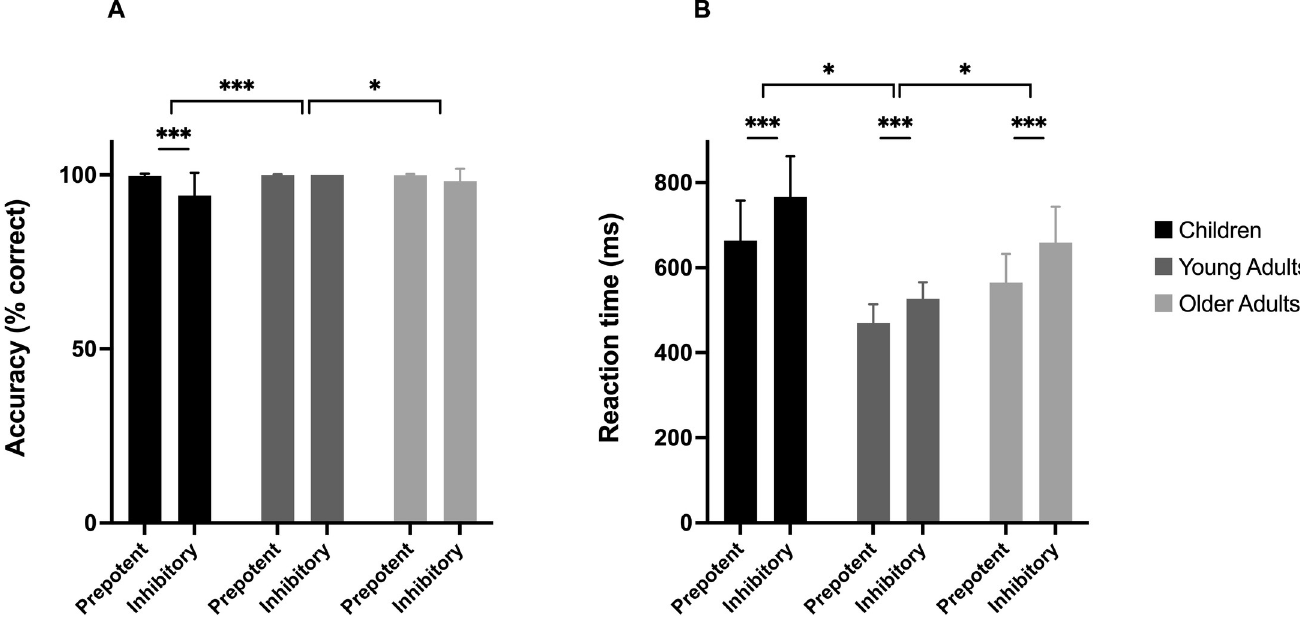
Fig 4. (A) Mean accuracy (%) and (B) mean median reaction time in milliseconds for inhibitory and prepotent trials in the Early Childhood Inhibitory Touchscreen Task–Adult version (ECITT-A) in Study 3. Brackets at the top indicate significant planned contrasts for the mean accuracy (AccD) and reaction time (RTD) difference scores. Error bars indicate the standard error. ��� p < .001, � p <